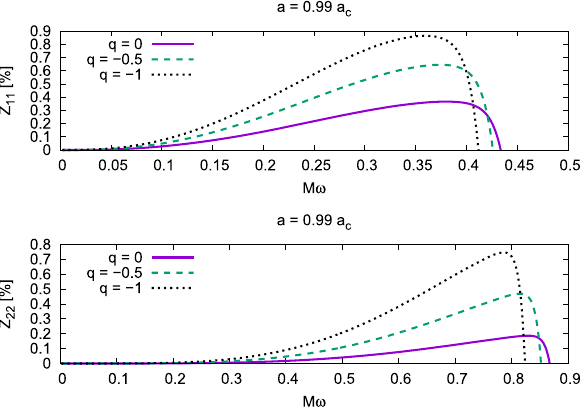
Fig. 6 Amplification factors for near-extreme black holes with q = 0 , − 1 . 0 , − 2 . 0 , − 2 . 5 and modes l = m = 1 , 2. Grid lines help us to visualize that maximum amplification in the cases q = − 2 . 0 , − 2 . 5 occurs for l = m = 2 instead of l = m = 1